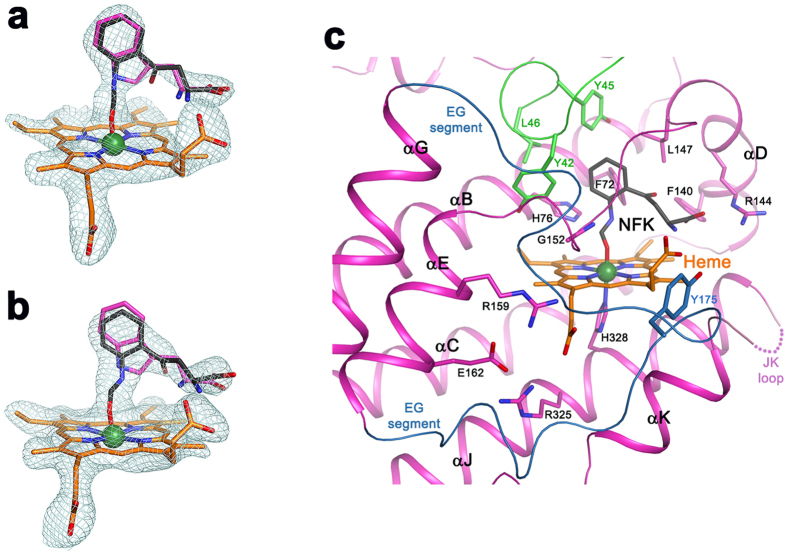
Molecular basis for NFK recognition by hTDO.(a) Omit Fo–Fc map at 2.5 Å resolution for heme and NFK in the active site of subunit C, contoured at 2.5σ. The binding mode of Trp in subunit A is shown as a reference. (b) Omit Fo–Fc map at 2.5 Å resolution for heme and NFK in the active site of subunit D, contoured at 2.5σ. (c) Schematic drawing showing the active site of hTDO in the binary complex with NFK in subunit D, where the JK loop is disordered (dotted curve).